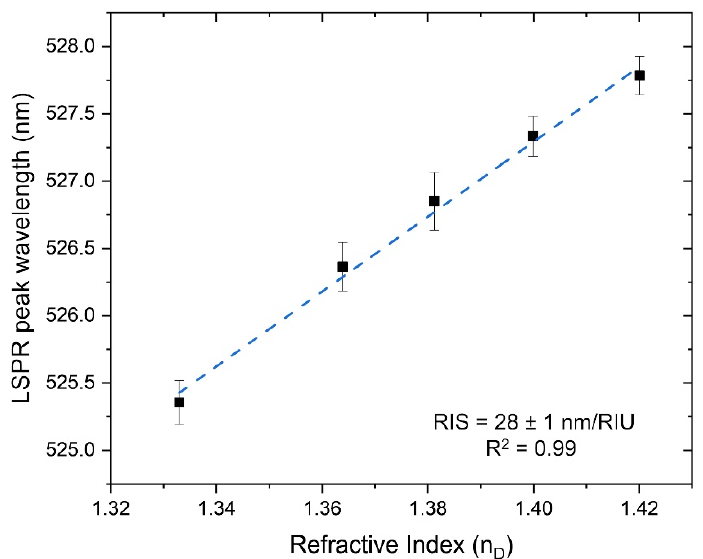
Figure 5. T-LSPR wavelength peak position of chitosan (0.5%)/Au-NPs plasmonic membrane as a function of the refractive index of the different solutions (water and sucrose at 20, 30, 40, and 50% (wt/wt)). The solid line is a linear fit applied to the